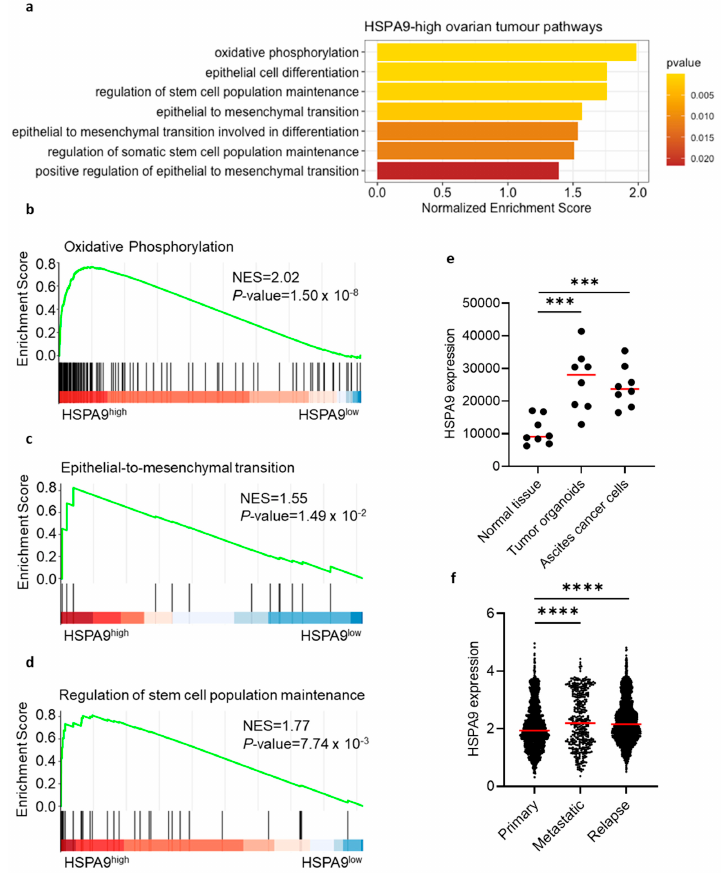
Figure 4. Mortalin gene expression correlates with cancer-related gene signatures in patients with ovarian cancer. Pathway enrichment using scRNA-seq in HSPA9 -high ovarian tumors ( a ). Correlation analysis of mortalin with OXPHOS-related genes ( b ), EMT genes ( c ), and stemness-like genes ( d ). Mortalin gene expression of malignant fluids of serous OC, including tumor-derived organoids and malignant effusion cells (no cultured) paired with normal ovarian tissues ( e ). Mortalin gene expression in primary, metastatic, and relapse tumors in HGSOC ( f ). p < 0.001 *** ; p < 0.0001 ****.